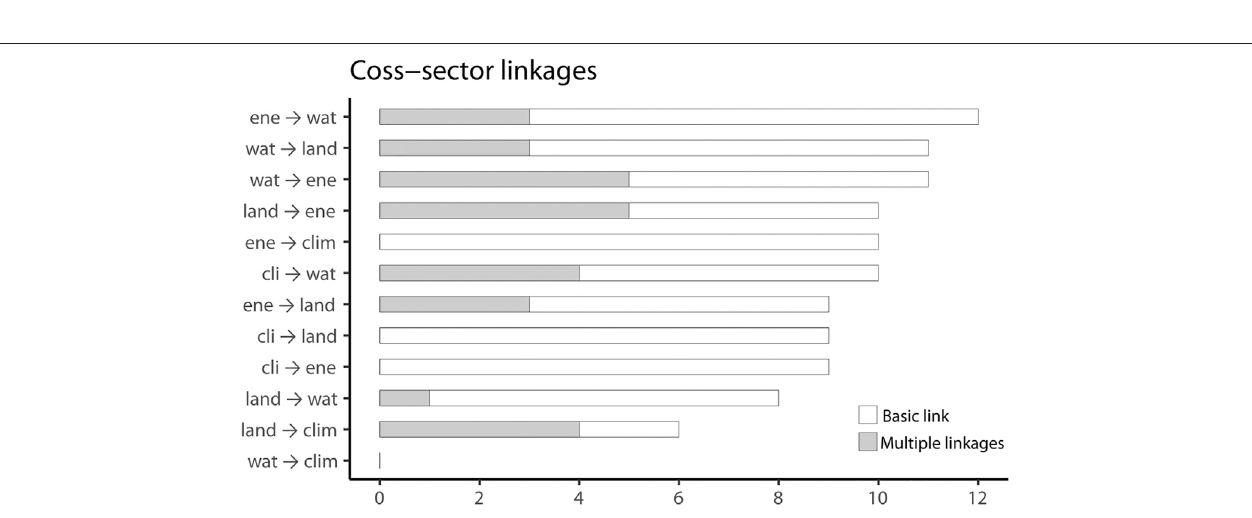
Frontiers in Environmental Science |